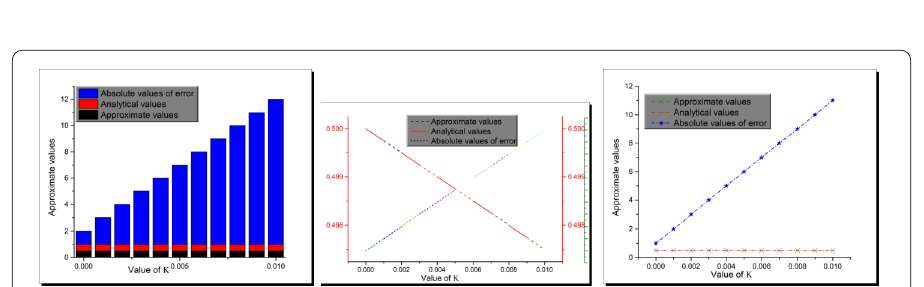
Figure 3 A comparison representation between analytical and numerical solutions of Eq. (2) according to the cubic-B-spline simulation